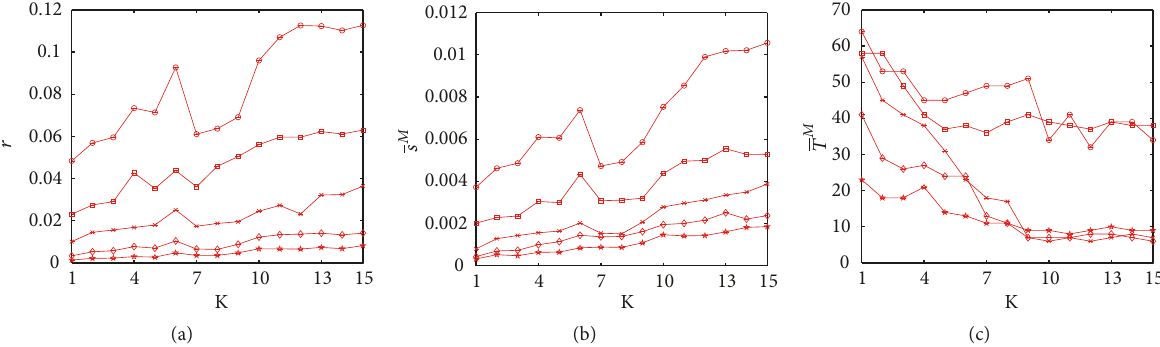
Figure 5: Three quantities of rumor propagation in Ca-GrQc network: (a) the average propagation size, (b) the average peak prevalence, and (c) the arrival time of the average peak prevalence when the spreading rate 𝛼 = 0.2(𝑠𝑡𝑎𝑟𝑠) , 𝛼 = 0.3(𝑑𝑖𝑎𝑚𝑜𝑛𝑑𝑠) , 𝛼 = 0.4(𝑓𝑜𝑟𝑘𝑠) , 𝛼 = 0.5(𝑠𝑞𝑢𝑎𝑟𝑒𝑠) , and 𝛼 = 0.6(𝑐𝑖𝑟𝑐𝑙𝑒𝑠) , respectively, and the decay rate 𝛽 = 1 . The performance of nodes in the higher layer is better.